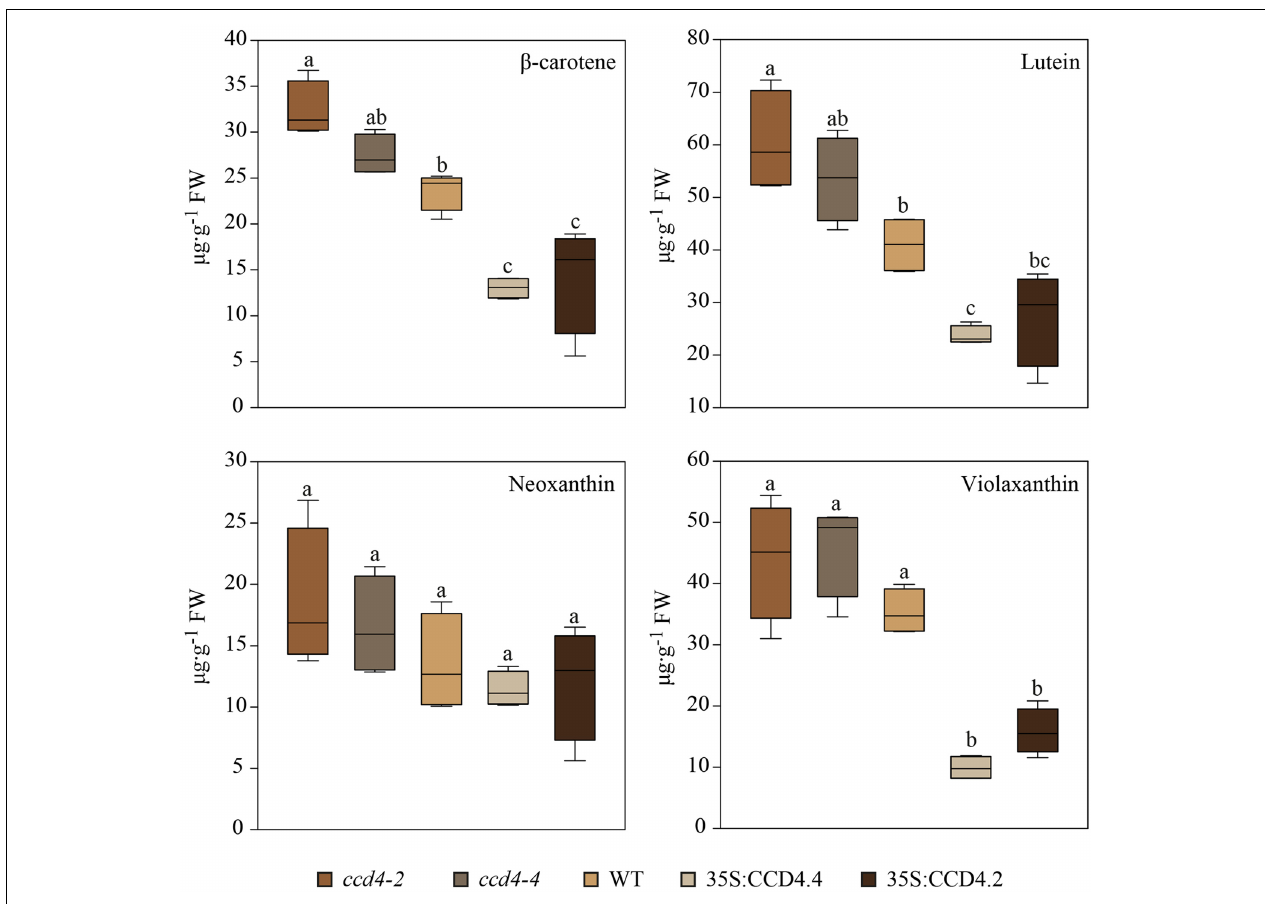
FIGURE 5 | Reduced level of photosynthesis-related carotenoids during senescence in CCD4 complemented plants. Detached leaves were placed in darkness for 8 days prior to lipid extraction ( n = 5 ). Lipids were separated by UHPLC-DAD following the carotenoid-profiling protocol. Absolute quantification of carotenoids was carried out on the basis of calibration curves obtained with pure standards. Box plots created with SigmaPlot are shown. Statistical differences across genotypes were assessed with a one-way ANOVA. Pairwise multiple comparisons (Holm–Sidak method) revealed significant differences (letters are distributed accordingly, P <